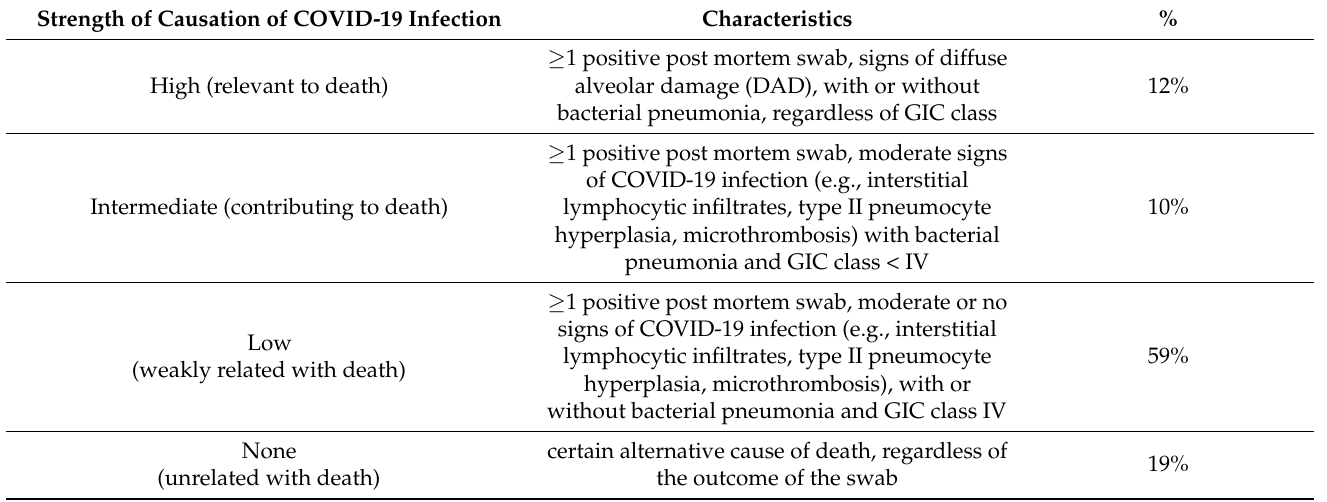
Table 4. Strength of causation between COVID-19 infection and